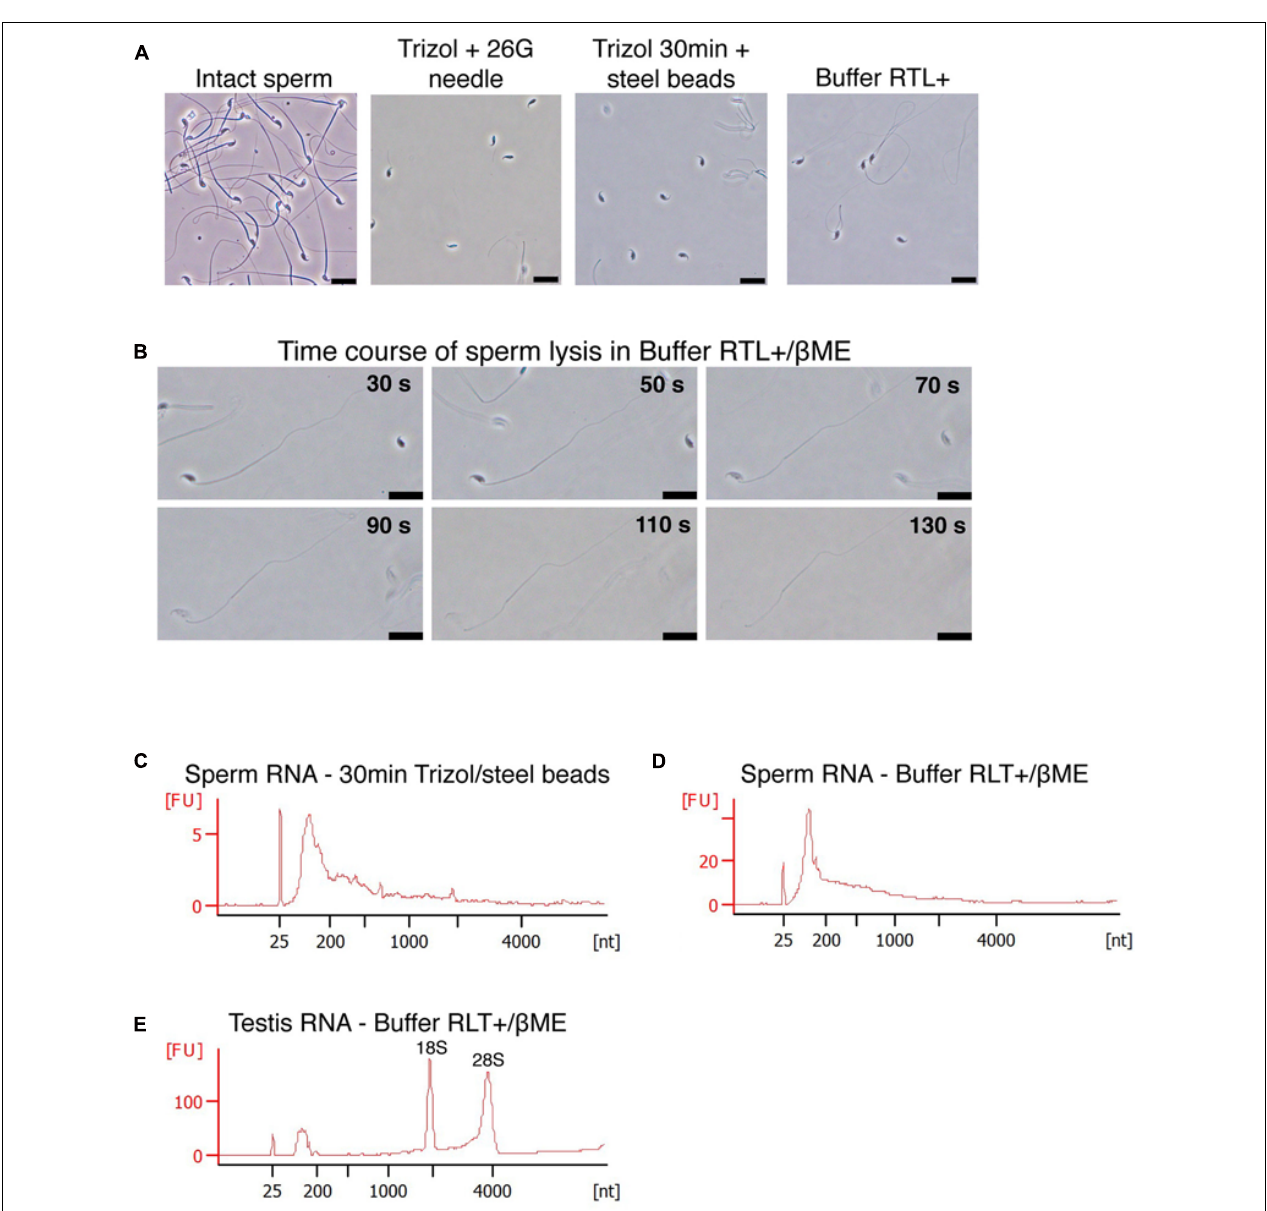
FIGURE 1 | Mouse sperm cells require reducing agents for lysis in chaotropic solutions. (A) Mouse sperm is not lysed in Trizol nor Buffer RLT+. Lysis is not improved by mechanical shearing. Scale bars = 20 µ m. (B) Mouse sperm is rapidly lysed by Buffer RLT+ supplemented with 50 mM β ME. Scale bars = 20 µ m.